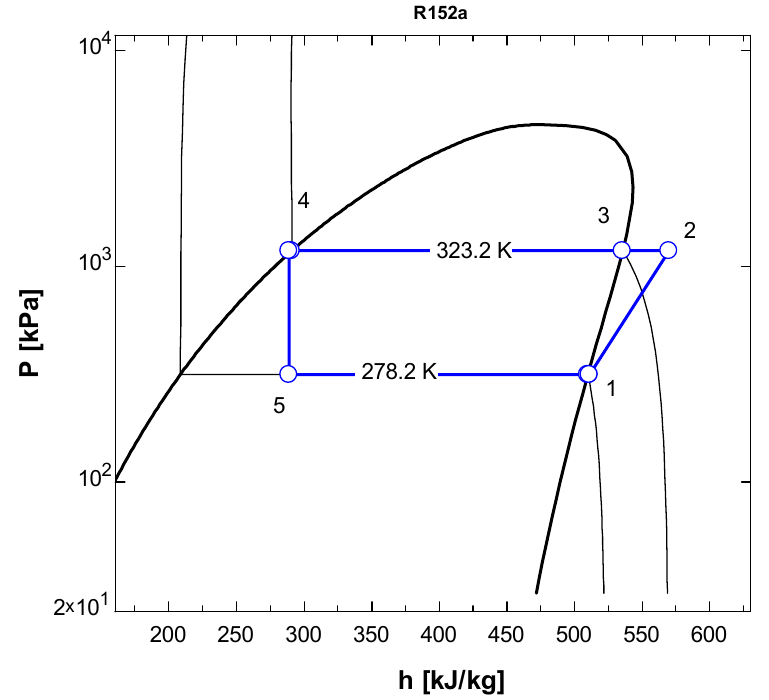
Figure 5. P-h diagram of vapor compression refrigeration cycle running with R152a . In the T-s diagram of R134a (Figure 2), the pressure at the condenser temperature was 1319 kPa, while the pressure was 349.9 kPa at the evaporator temperature. In the T-s diagram of R152a (Figure 4), the pressure at the condenser temperature was 1179 kPa, while at the evaporator temperature, the pressure was 1315.21 kPa. In both Figures 2 and 4, it may be observed that the compression (1-2) is not isentropic as the line is not vertically straight but inclined to right indicating increase in entropy. When the superheated vapour